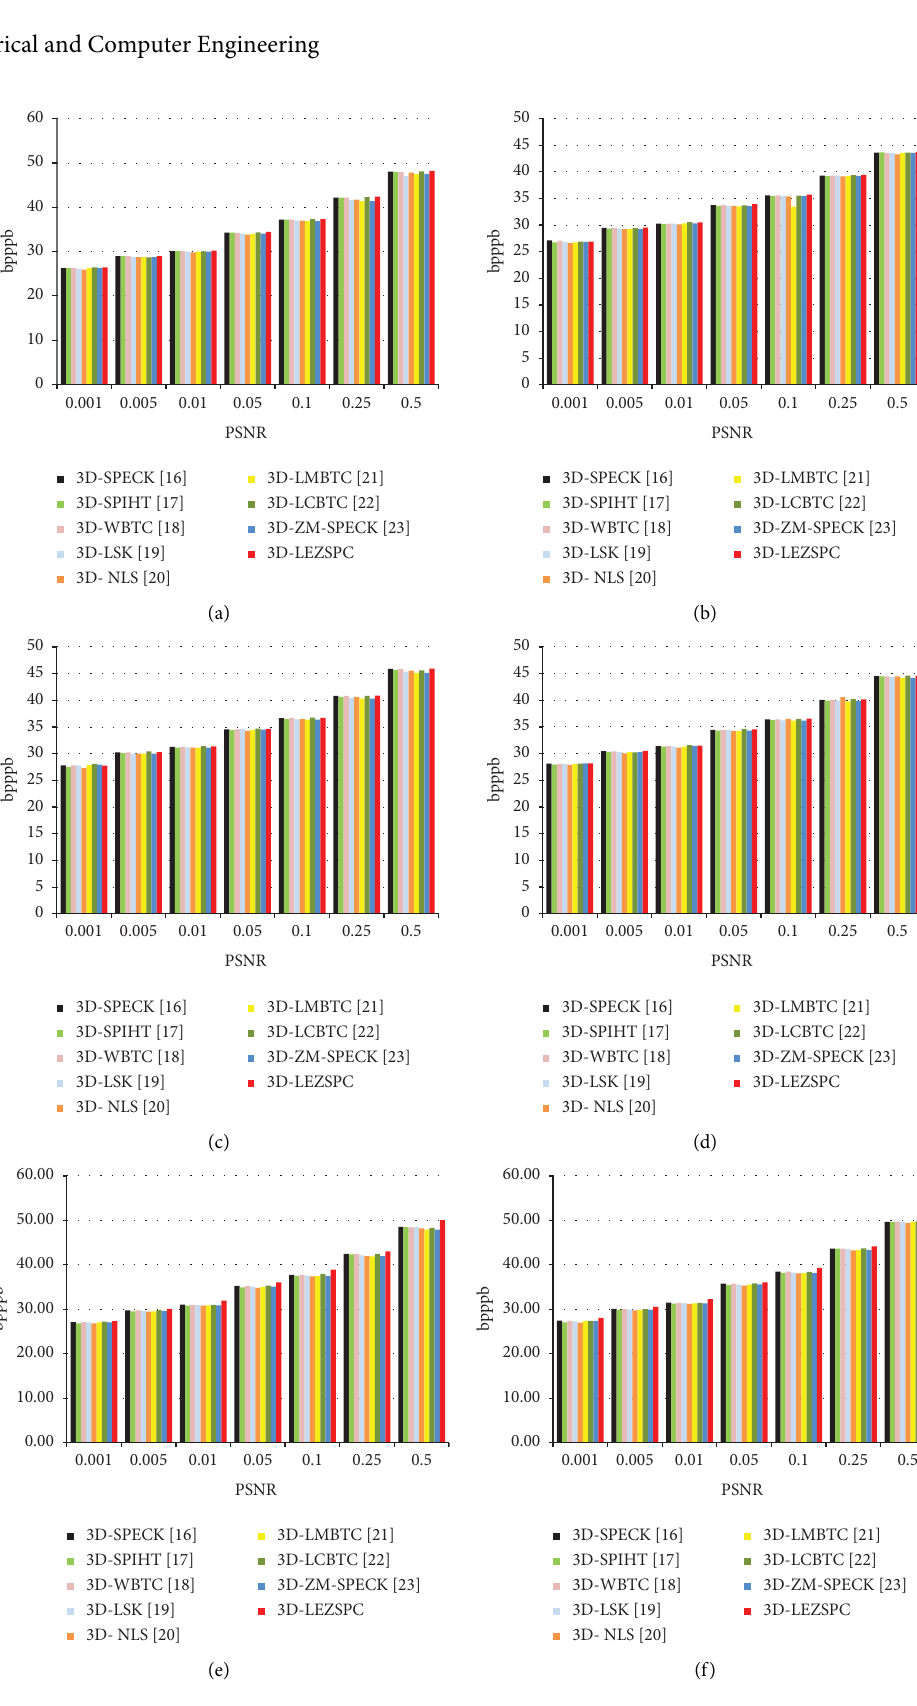
Figure 1: PSNR (in db) comparison of 3D-LEZSPC with 3D-SPECK [16], 3D-SPIHT [17], 3D-WBTC [18], 3D-LSK [19], 3D-NLS [20], 3D- LMBTC [21], 3D-LCBTC [22], and 3D-ZM-SPECK [23] at various bit rates for the four diferent hyperspectral